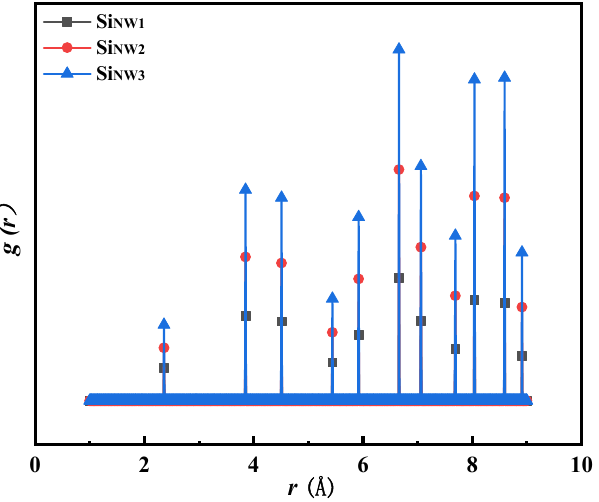
Figure 2. Pair distribution functions g ( r ) of the three Si NWs before relaxation.